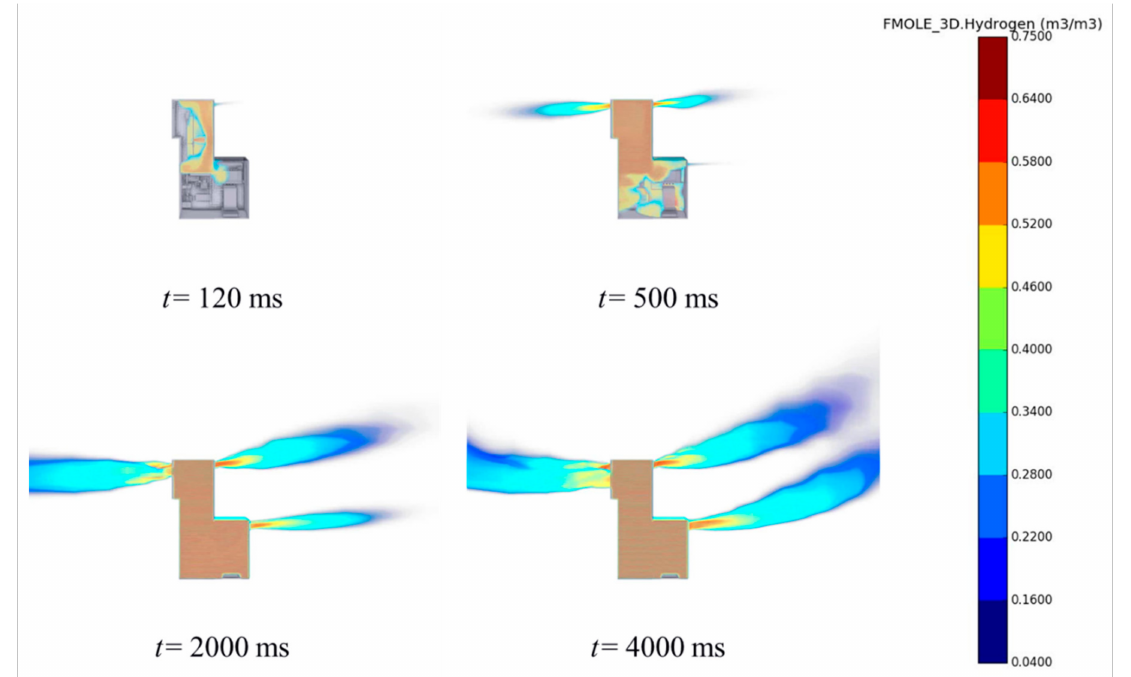
Figure 3. Volume fraction of hydrogen of Case 1.